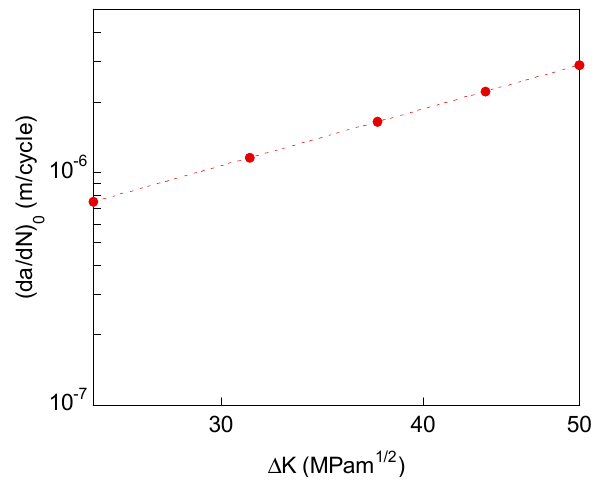
Figure 5. Plasticity-induced fatigue crack propagation curve in the Paris regime.